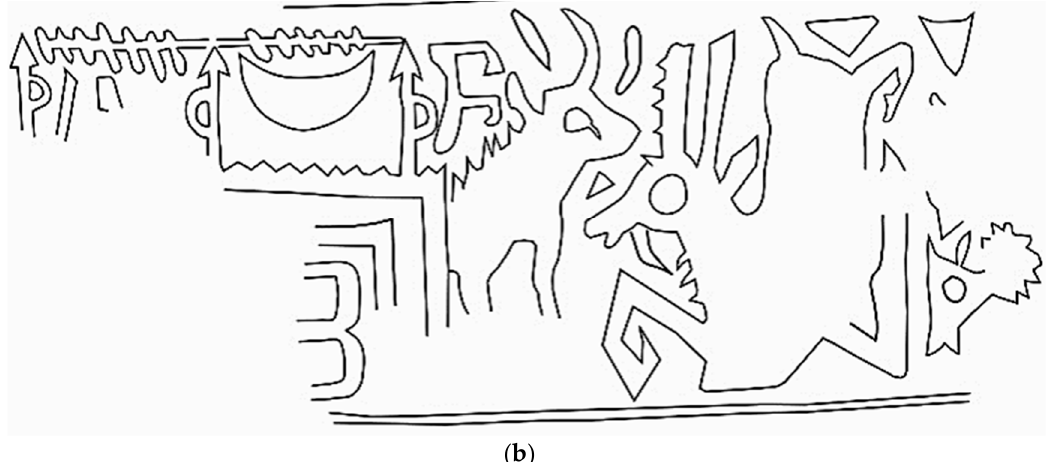
Figure 17. ( a ) Ubaid temple inlaid frieze: cow pen with lunar crescent (Delougaz 1968: Figure 15). ( b ) Seal impression showing cow pen with lunar crescent from Konar Sandal (Pittman 2012: Figure 5b).